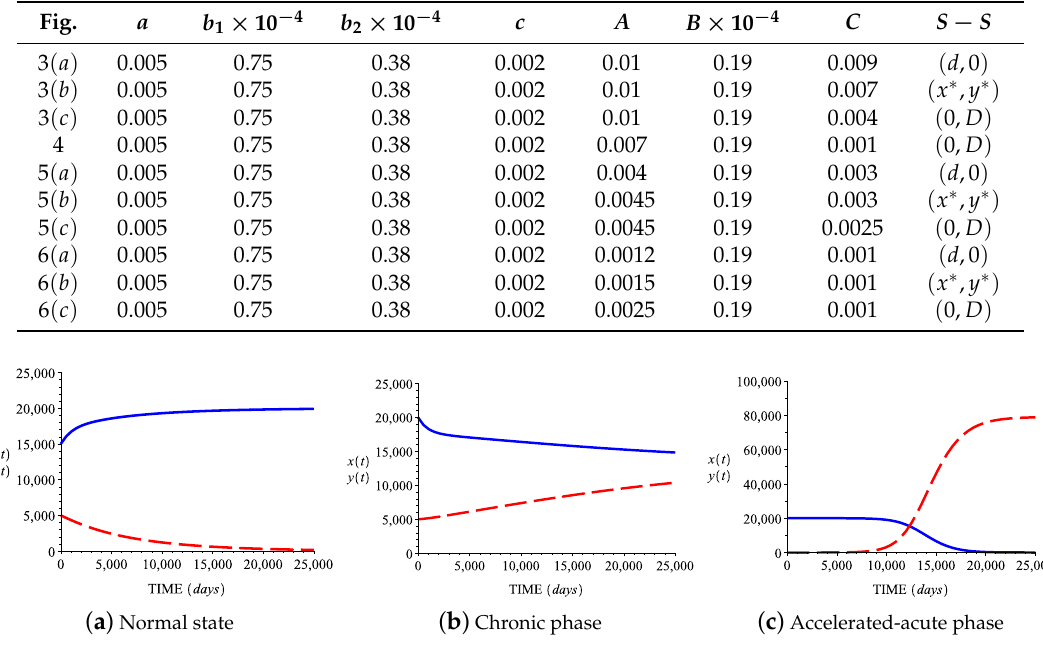
Figure 6. Behavior of the normal and leukemic stem cell populations in Case IV. Initial conditions: ( a ) x ( 0 ) = 1.5 × 10 4 , y ( 0 ) = 5 × 10 3 ; ( b ) x ( 0 ) = 2 × 10 4 , y ( 0 ) = 5 × 10 3 ; ( c ) x ( 0 ) = 2 × 10 4 , y ( 0 ) =